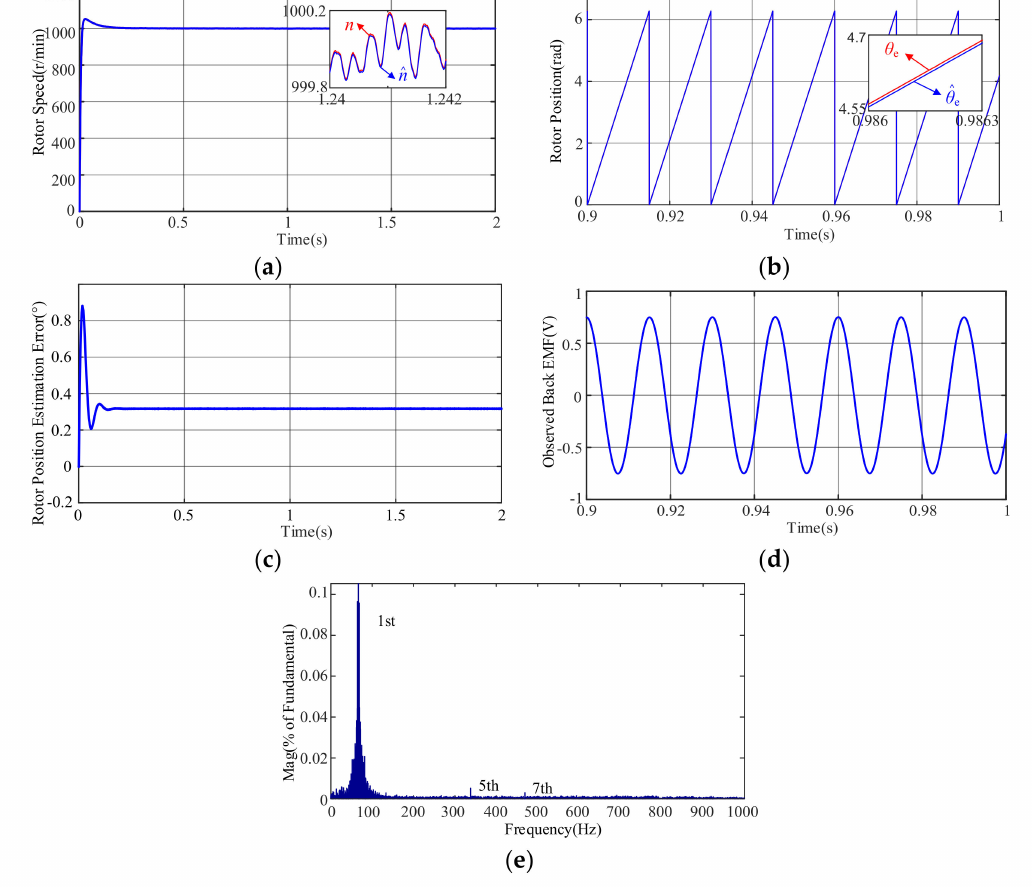
Figure 10. Analysis of estimated extended back-EMF by the SFT-based sensorless speed control method for an IPMSM. ( a ) Estimated and measured rotor speed; ( b ) Estimated and measured rotor position; ( c ) Rotor position estimation error; ( d ) Estimated back-EMF; ( e ) the FFT of estimated